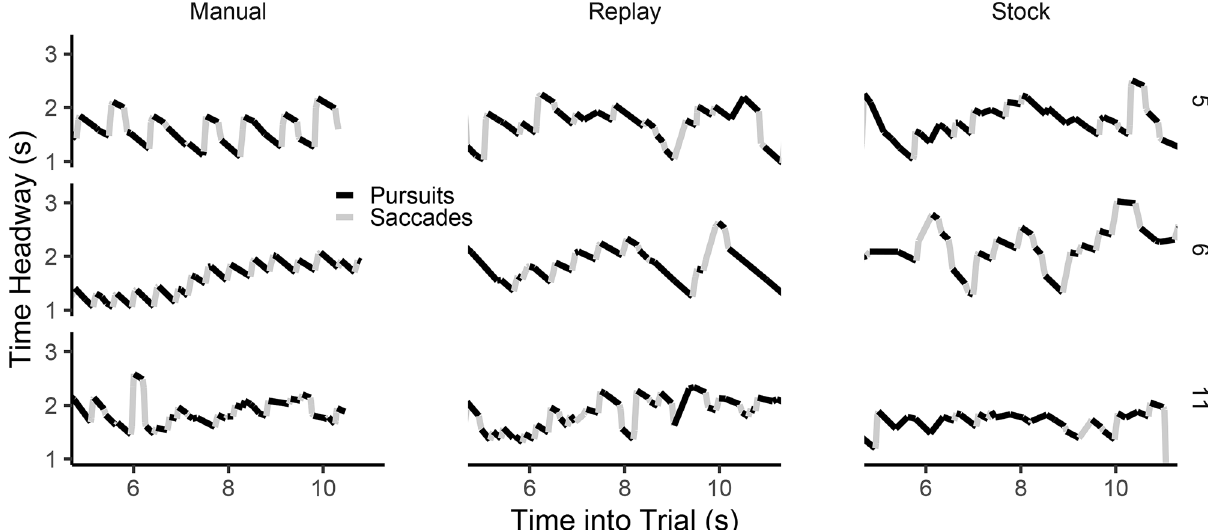
Figure 9. Example gaze traces. Three randomly selected participants (rows) and trials (panels) for Manual (left), Auto-Replay (the same trial replayed; centre), and a Auto-Stock trial (right).